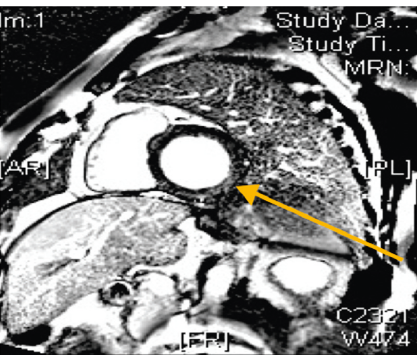
Figure 2: Cardiac MRI inversion recovery images after contrast injection revealing mild mid-wall enhancement in the basal inferior and inferolateral walls consistent with myocarditis